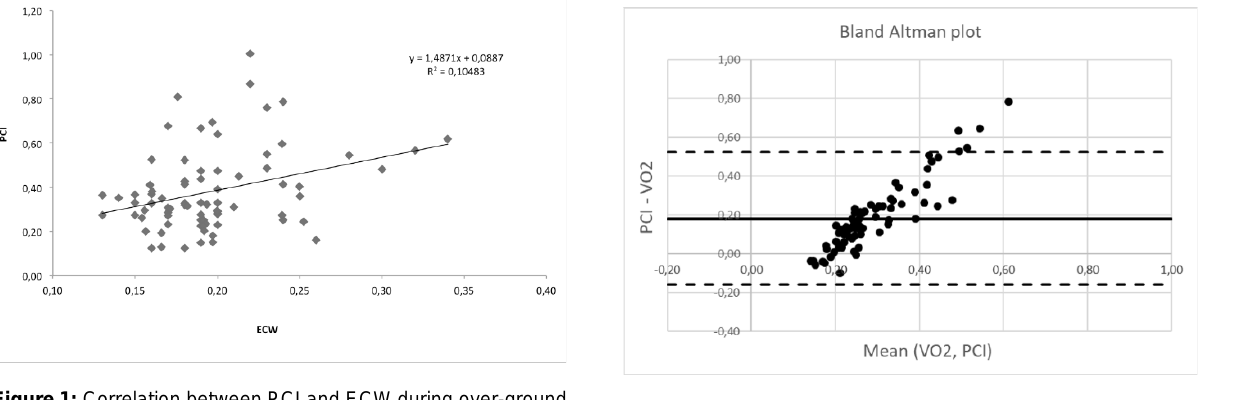
Figure 4: Bland-Altman plot of PCI and VO2 for over-ground